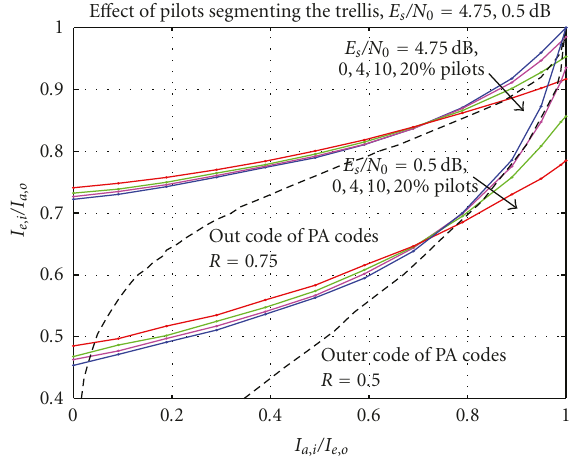
0 Figure 9: The e ff ect of pilot symbols segmenting the trellis on the performance of the di ff erential decoder. Normalized Doppler rate f d T s = 0 . 01, E s /N 0 = 4 . 75 dB and 0dB, perfect CSI.